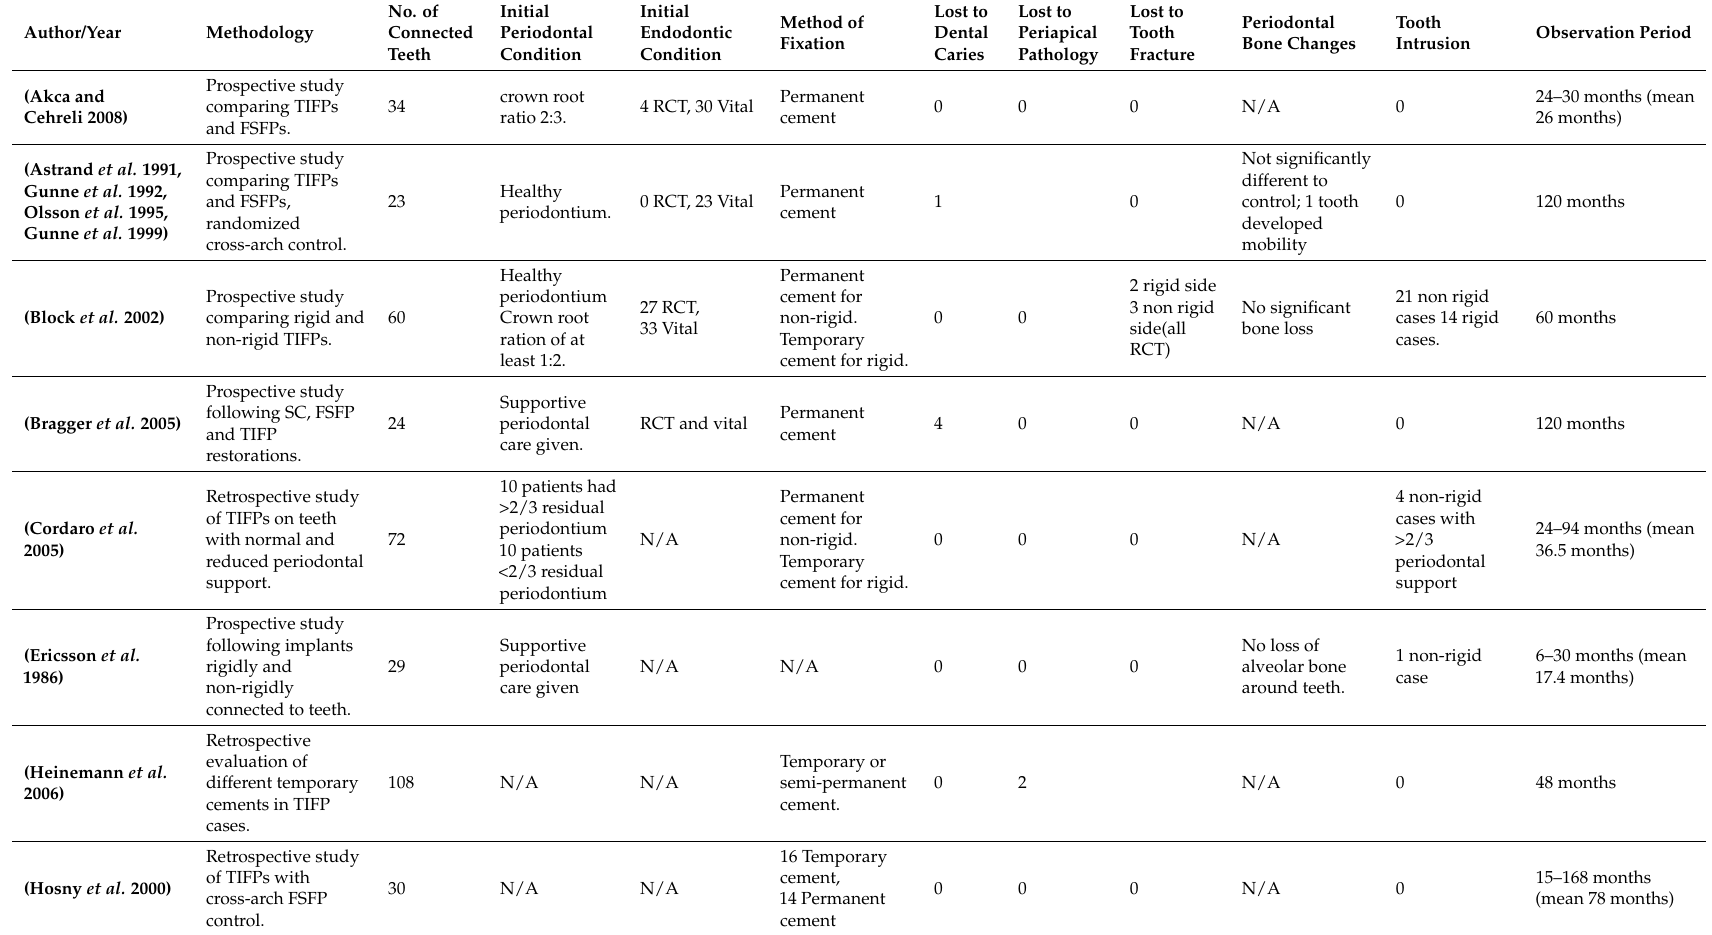
Table 5. Table of studies detailing failures of natural teeth supporting